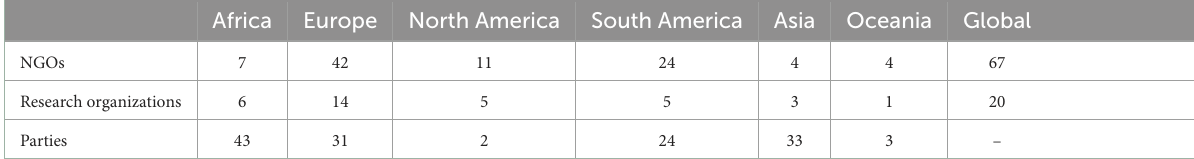
TABLE 3 The number of submissions deemed to have a (implicit or explicit) justice-related reference by NGOs, research and parties on justice showing the geographical region represented by the submitting organization. Africa